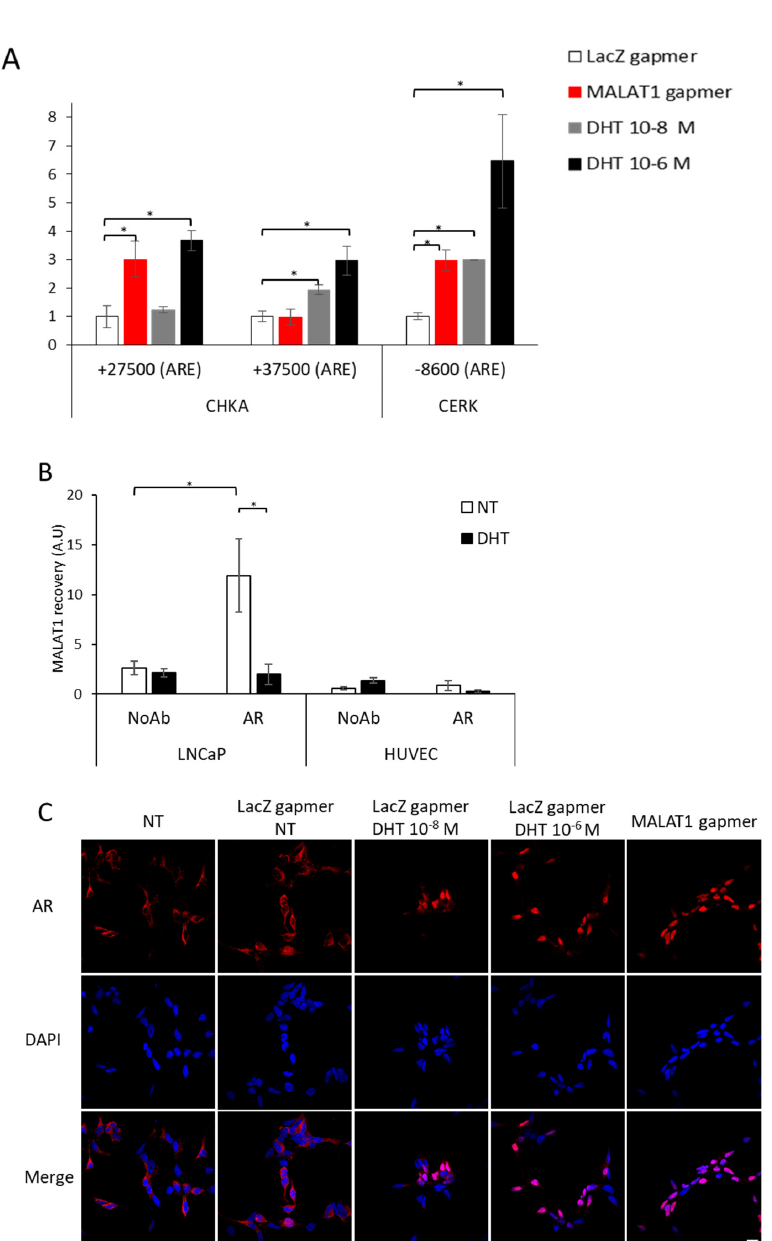
Figure 7. AR recruitment by ChIPs on CHKA and CERK regulatory regions and AR nuclear translocation upon MALAT1 targeting or dihydrotestosterone (DHT) treatment and MALAT1/AR interaction by RIP: ( A ) AR recruitment onto CHKA ARE located at +27,500 and +37,500 bp from TSS (Intronic region) and CERK ARE located at − 8500 bp from TSS or after MALAT1 gapmer transfection (16 h) or DHT treatment (10 –8 M and 10 –6 M 4 h). No Antibody (NoAb) served as a negative control. Data represented as the mean of AR fold change after subtraction of NoAb ± SEM (N = 2). * p < 0.05 vs. gapmer LacZ. ( B ) MALAT1 interaction with AR in LNCaP and HUVEC cells (used as control) before and after DHT (10 –7 M, 1 h) treatment detected by RIP assay. RIPs were performed using antibodies specific to AR or in the absence of Ab (NoAb) as a negative control. RNA was recovered and analyzed by qRT-PCR. Data are represented as mean ± SEM of two independent experiments performed in duplicate. * p < 0.05. ( C ) Androgen receptor subcellular localization was evaluated by confocal microscopy upon MALAT1 gapmer delivery (16 h) or DHT treatment (10 − 8 M or 10 − 6 M for 4 h). Scale bar: 15 µm.